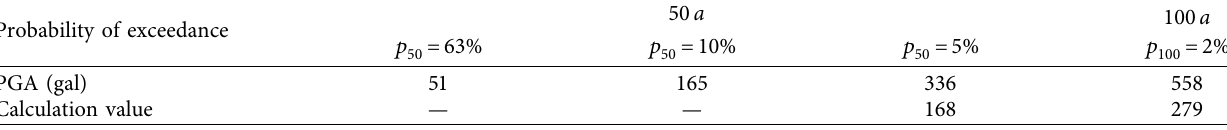
Table 4: Reference earthquake motion parameters of the Dagangshan hydropower plant.